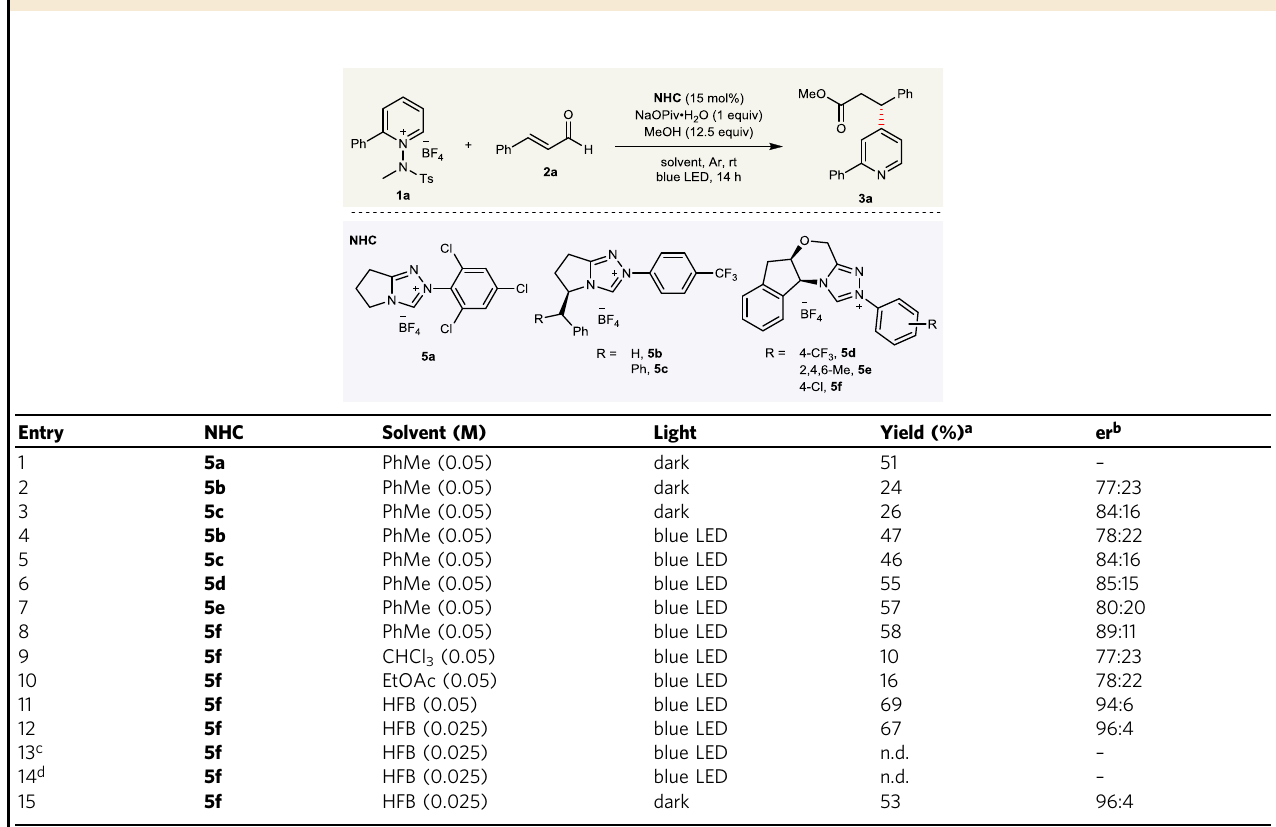
Table 1 Optimization of the reaction